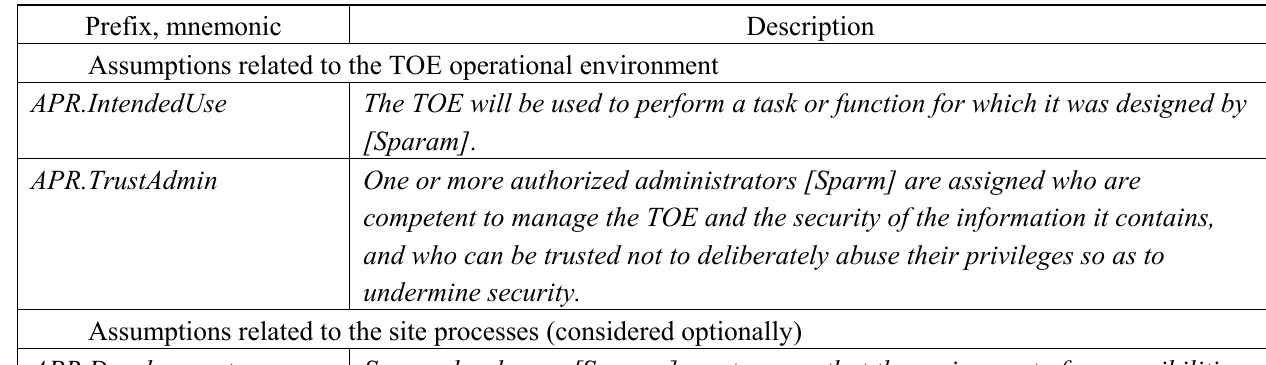
Table 14. Enhanced generics representing